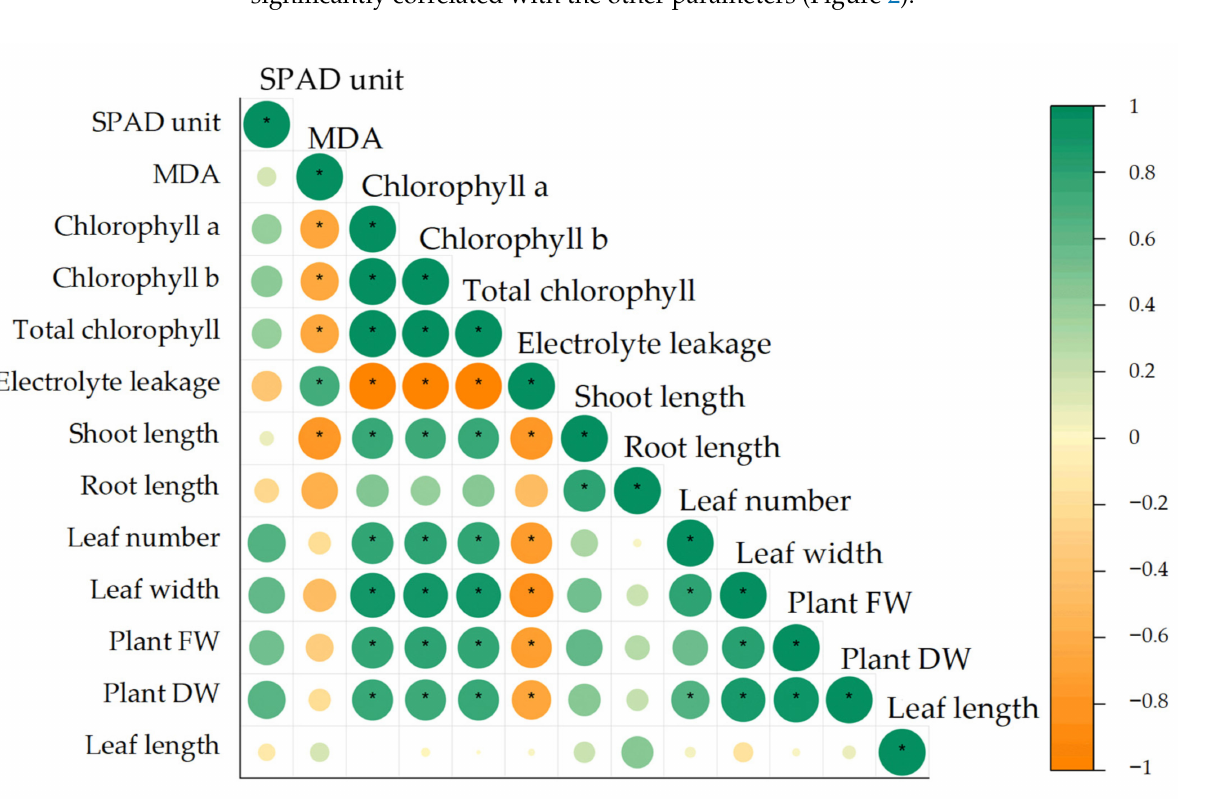
Figure 2. Pearson’s correlation among growth and physiological parameters of KDML105 seedlings to heat stress (asterisk, p <